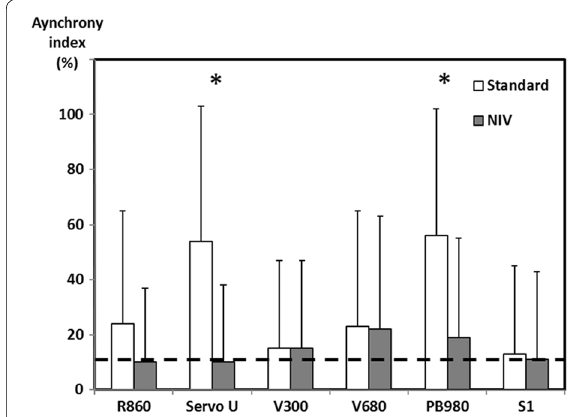
Fig. 4 Asynchrony index with or without the non-invasive ventila- tion mode. The asynchrony index (AI) is presented as mean SD ± and was measured under three different levels of exponential leaks (L1 3.5–4.0 L min − 1 ; L2 5.0–7.0 L min − 1 ; L3 9.0–12.5 L min − 1 ) = = = and three levels of inspiratory effort (P0.1 2, 4, 8 cmH 2 O). ‘Standard’ = represents measurements performed under PC-CSV using unmodi- fied manufacturers’ settings in terms of inspiratory and